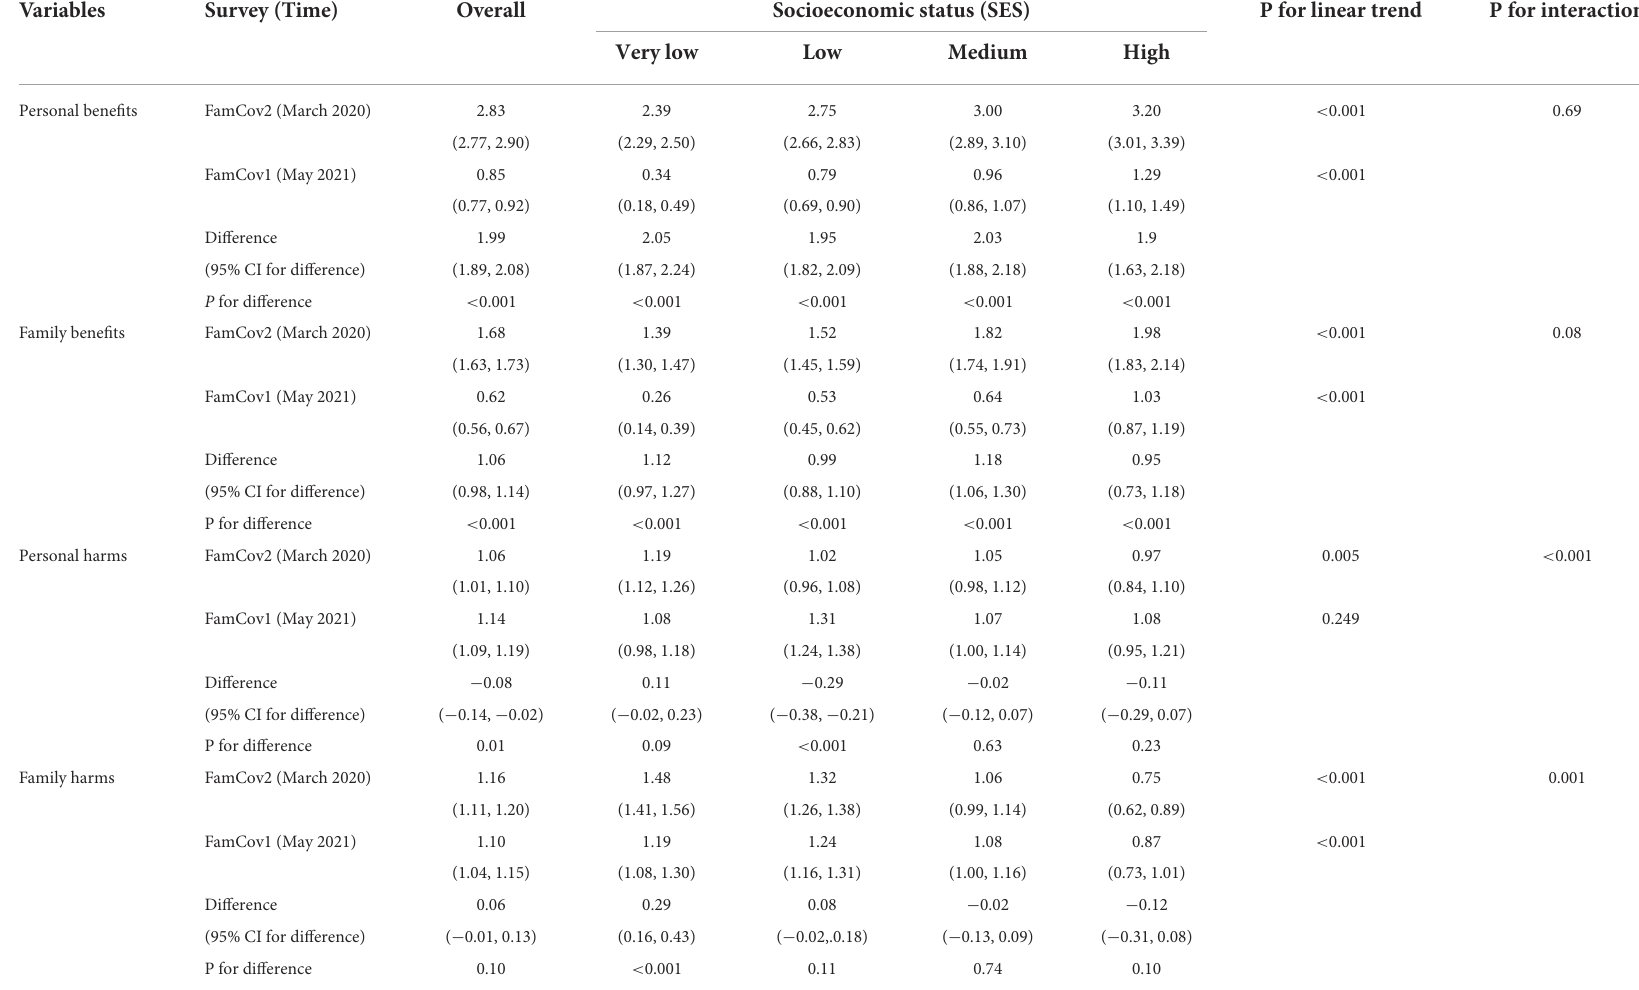
TABLE 3 Weighted sex- and age-adjusted estimated marginal means (95% confidence intervals) and the multivariate model of analysis of covariance for the total number of perceived personal benefits, family benefits, personal harms, and family harms in FamCov1 (May 2020) and FamCov2 (March 2021) surveys.